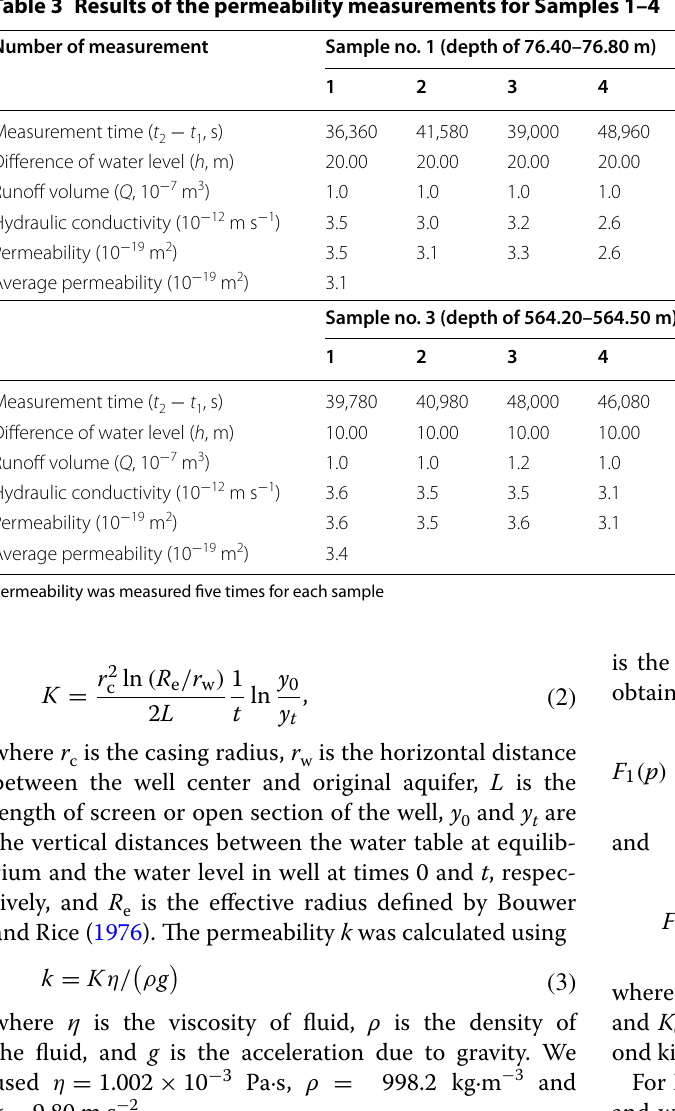
Table 3 Results of the permeability measurements for Samples 1–4 Number of